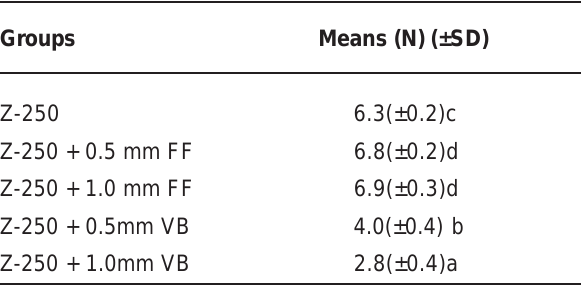
TABLE 2- Means (±SD) and statistical analysis of polymerization contraction forces of Z-250 composite resin, Filtek Flow flowable composite and Vitrebond resin-